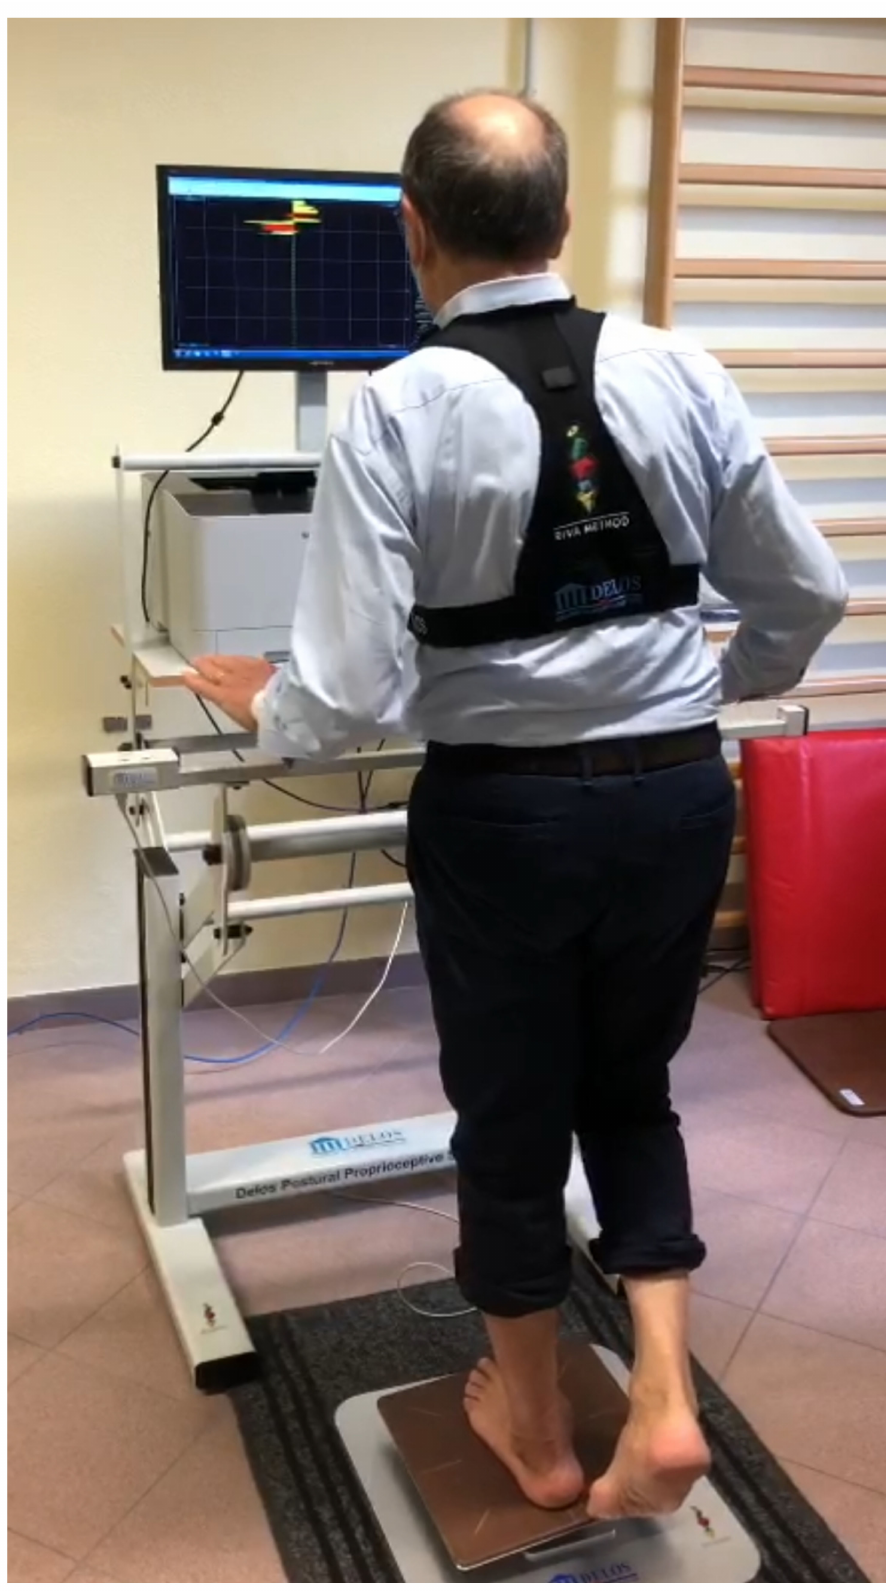
Figure 4. Dedicated Delos